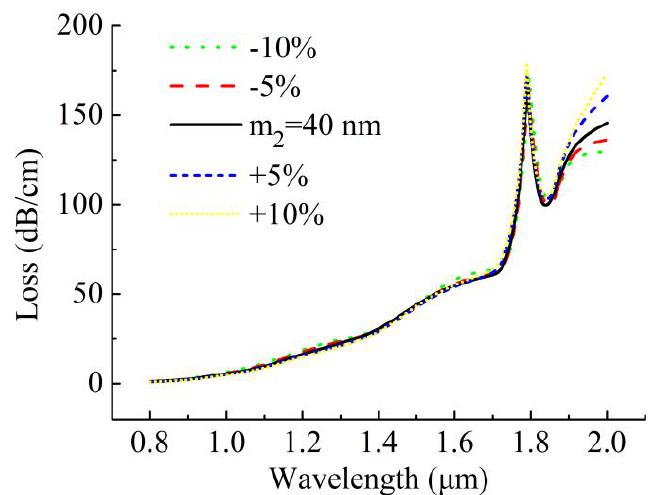
Figure 4. Loss spectra of y -polarized core mode at n a = 1.47 when m 1 is fixed at 40 nm and m 2 changes in the range of ±10%. Table 1. Summary of peak wavelengths, peak losses and sensitivities of y -polarized core mode at the n a range of 1.33 – 1.49, when m 1 is fixed at 40 nm and m 2 changes in the range of ±10%.